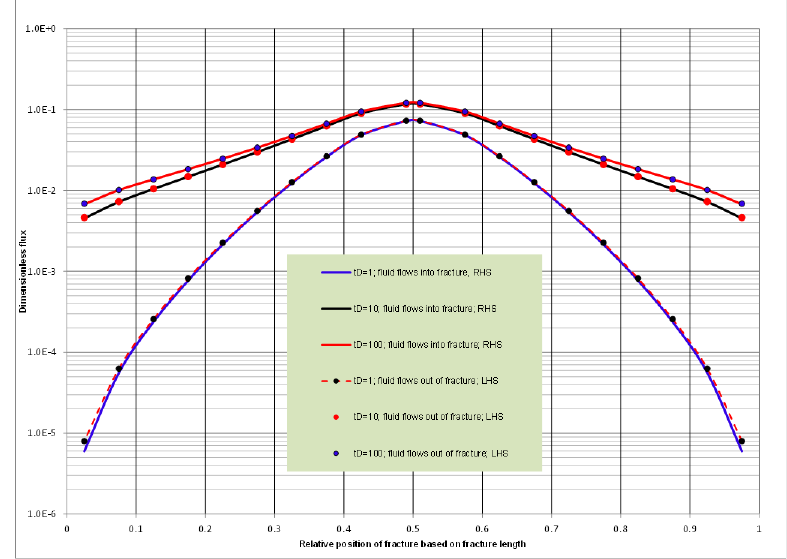
Figure 13. Flux profiles along the LHS and RHS of the isolated fracture of 𝑘 𝑓𝑟𝑎𝑐 /𝑘 𝑚𝑎𝑡𝑟𝑖𝑥 = 0.01 , with 𝑊 𝐷 = 50 , 𝐻 𝐷 = 50 , 𝑤 𝑓𝐷 = 0.01 , 2𝐿 𝑓𝐷 = 10 , and 𝑋 𝑣𝐷 = 2 .